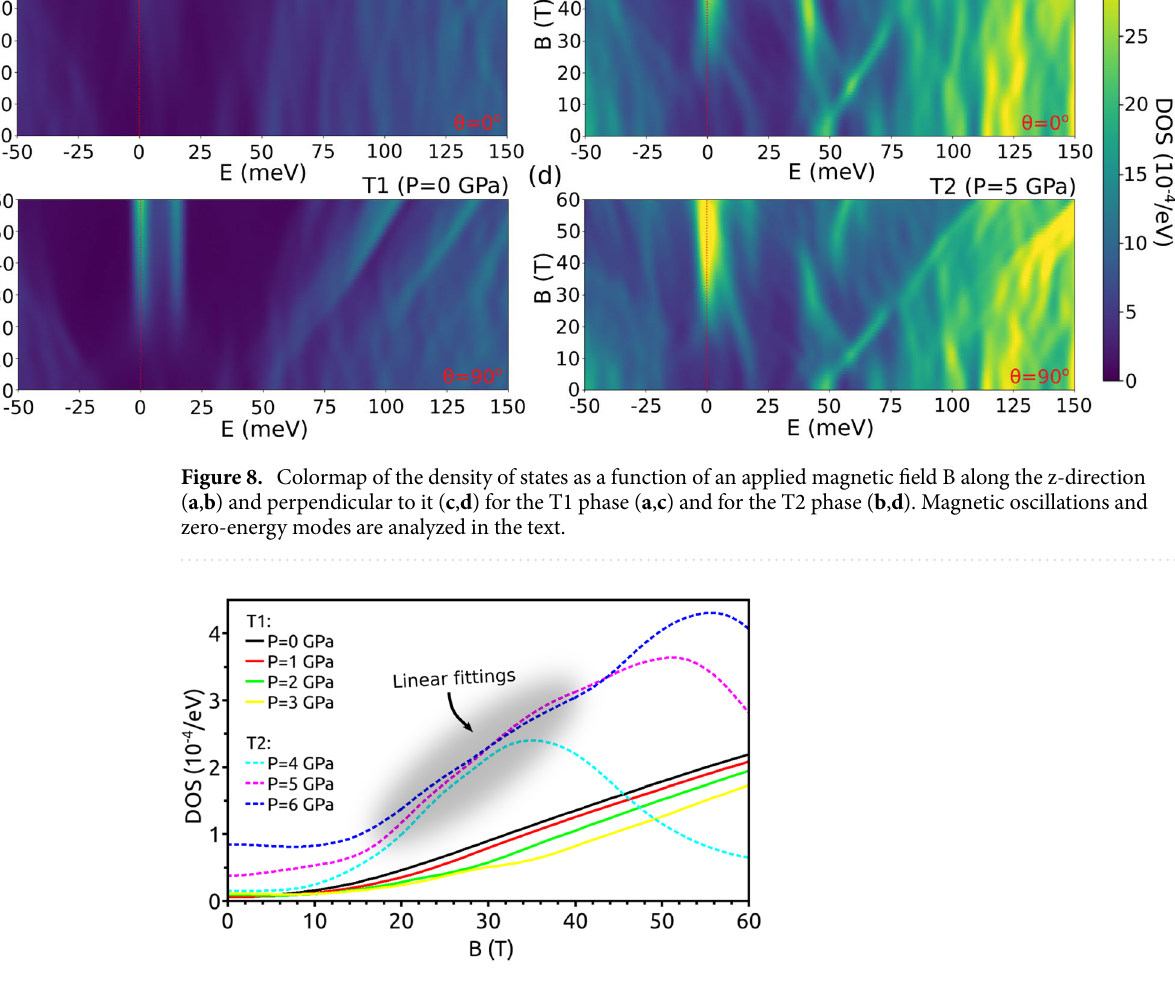
Figure 9. Zero-energy modes for different pressures as a function of the magnetic field. Linear fittings were performed for each phase. The ratio between slopes is 1.98, demonstrating the existence of a topological-to- topological phase transition (see